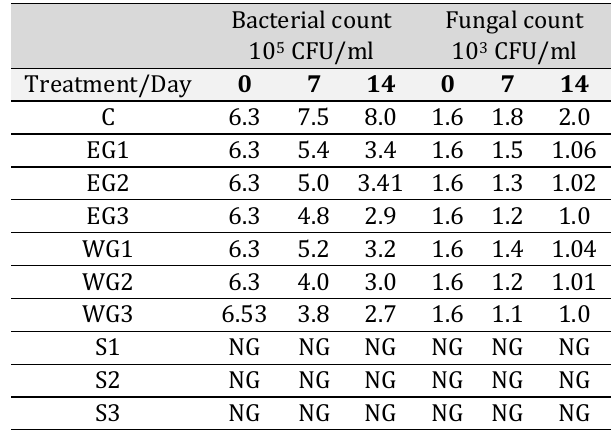
Table 2. Microbial counts of treated raw palm oil samples at each day of